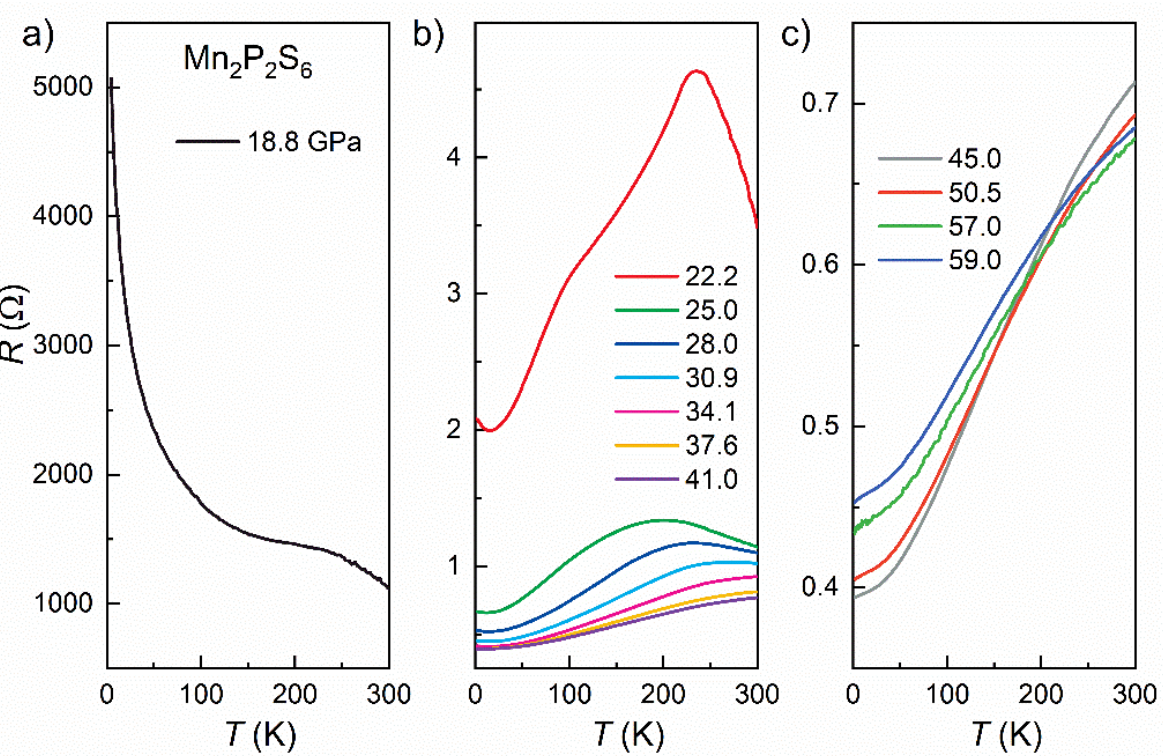
Figure 10. Evolution of the resistivity for Mn 2 P 2 S 6 as a function of temperature under different applied hydrostatic pressure. ( a ) 18.8 GPa, ( b ) 22.2–41.1 GPa and ( c ) 45.0–59.0 GPa.